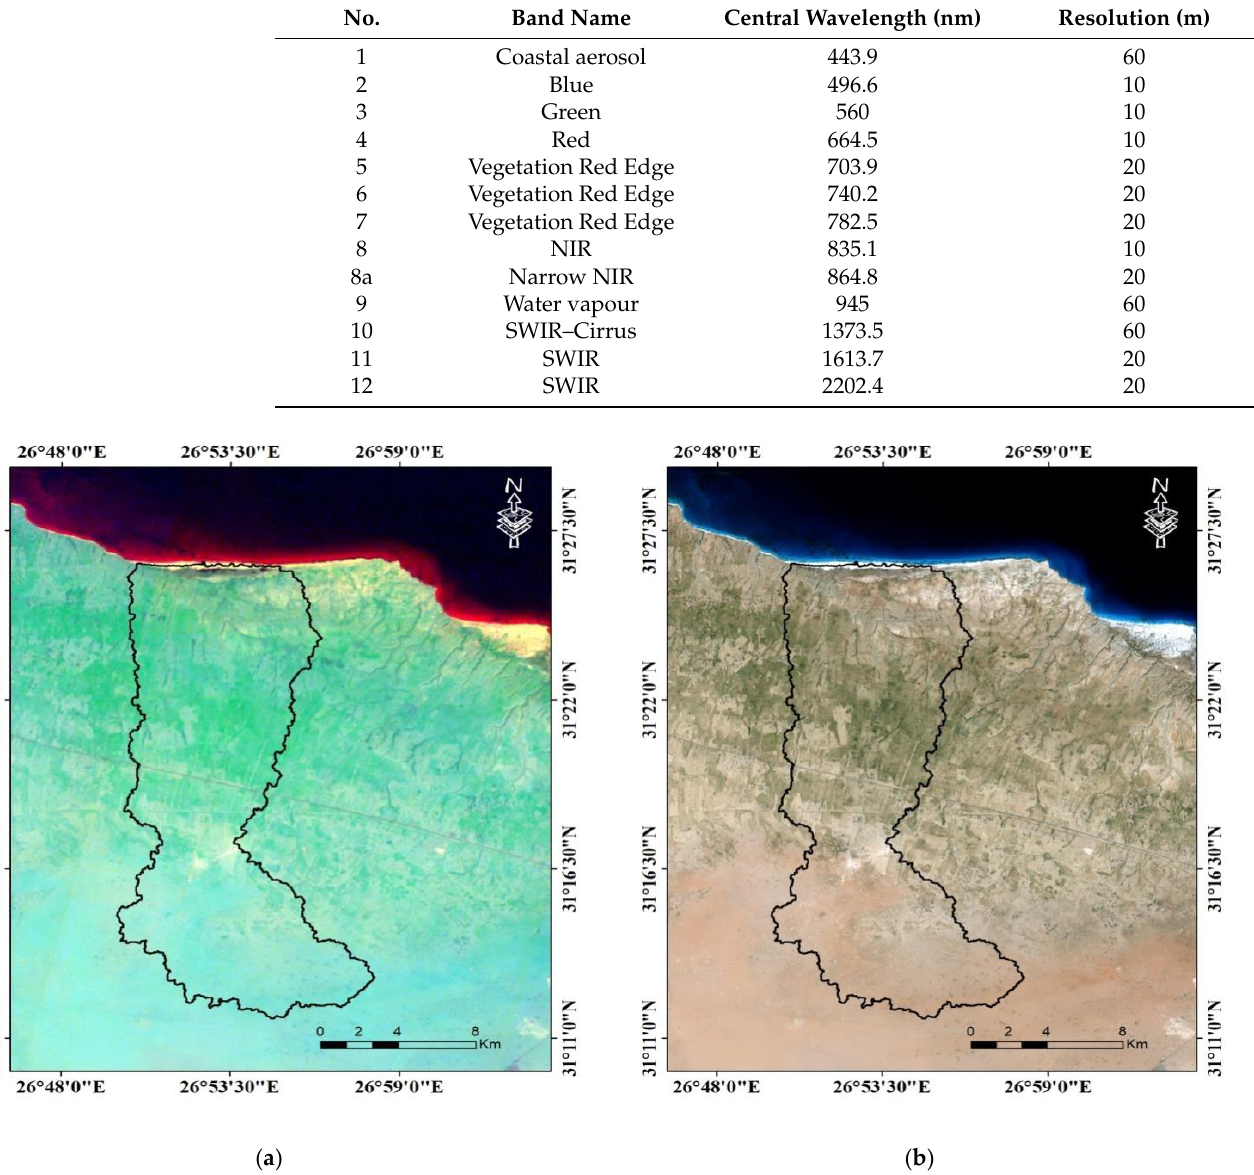
Table 1. Characteristics of the Sentenial2 satellite image.